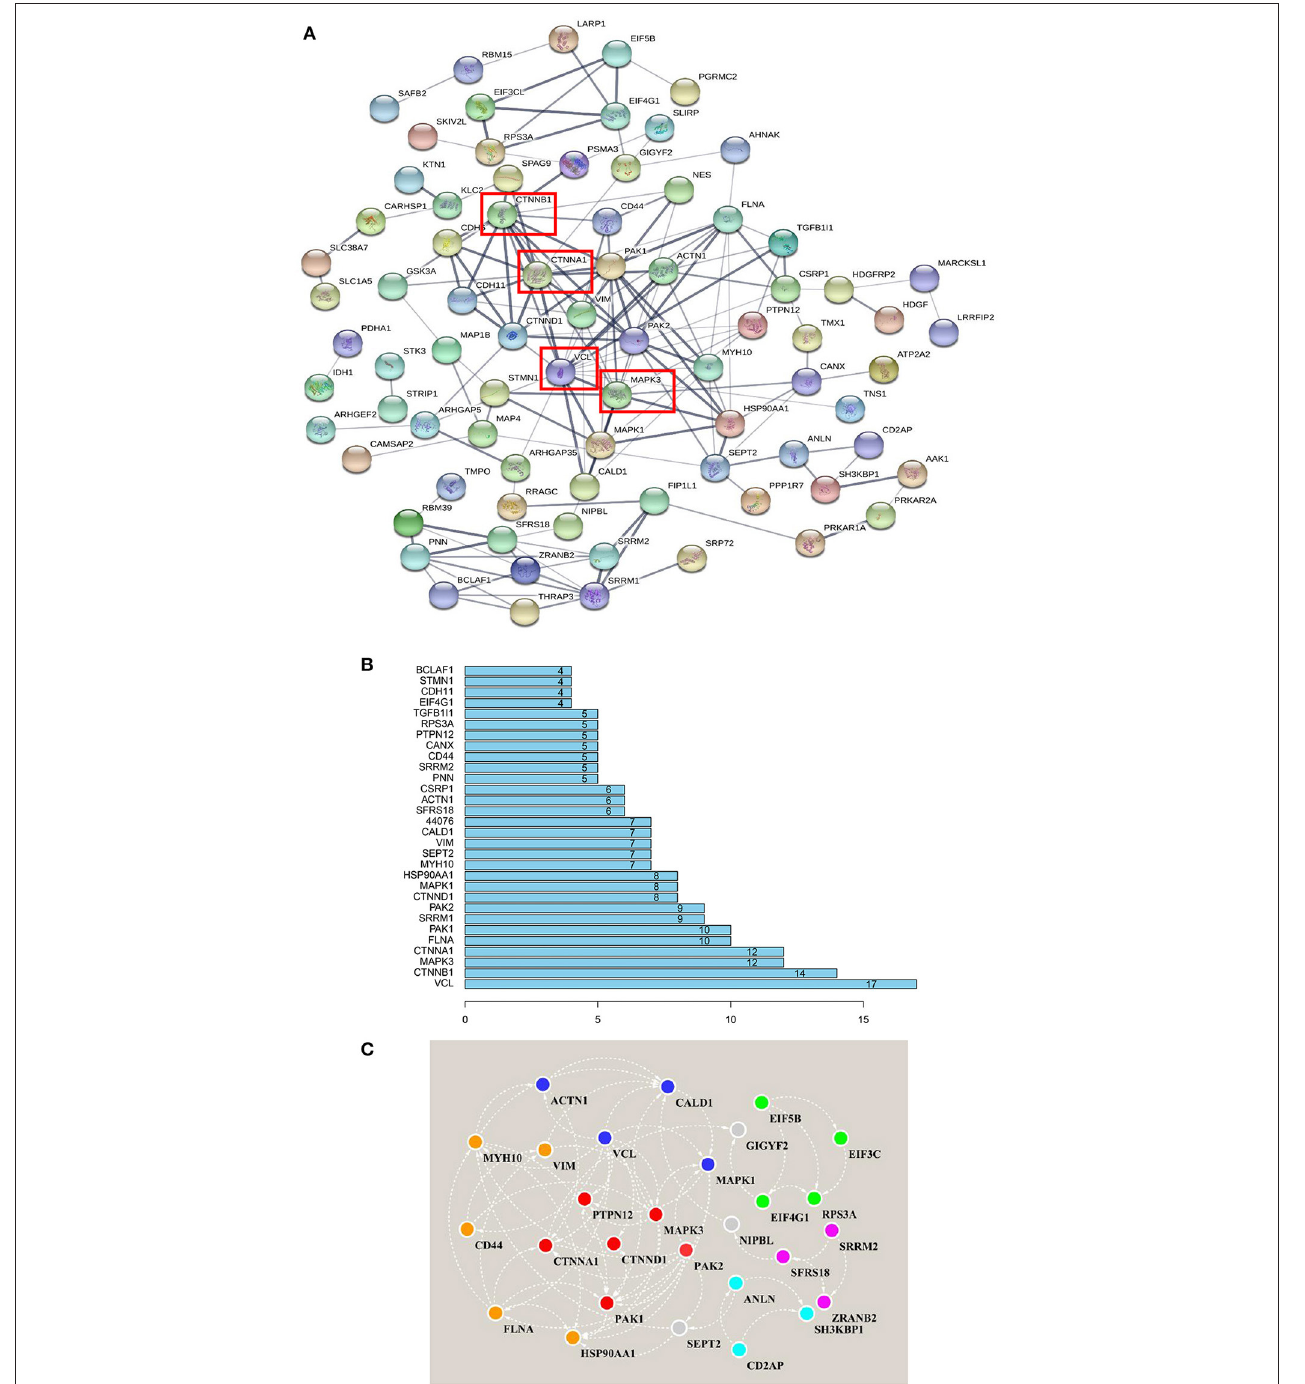
FIGURE 6 | Interaction network analysis, based on the phosphorylated proteins positively associated with amino acid signals. (A) Proteins that were positively associated with all amino acid signals were input to the String database to perform network analysis. The string network indicated that VCL, CTNNB1, MAPK3, and CTNNA1 serve as the center of the entire network, with high credibility. Network nodes represent proteins, and network edges represent protein-protein associations. Empty nodes represent proteins of unknown 3D structure, whereas filled nodes represent proteins for which some 3D structure is known or predicted. The thicker the edges, the higher the confidence. (B) The distribution of protein nodes, showing the top 30 notes from (A) . (C) The raw data from the String interaction network analysis were input into Cytoscape software to predict subnetworks. Five subnetworks were identified, closely related to cytoskeletal regulation and protein synthesis. The same color nodes are used for the